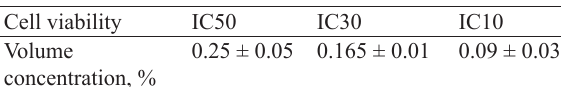
Table 4 Effect of raspberry extract on cell viability of the supercritical HCT-116